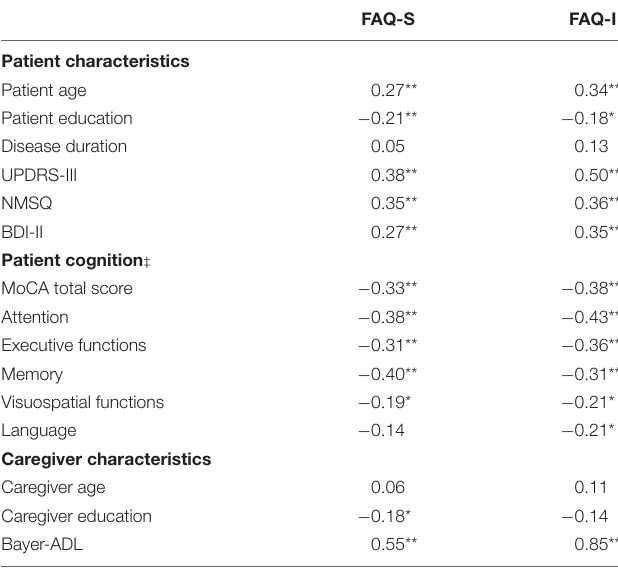
TABLE 4 | Correlations between the total FAQ-S and FAQ-I scores and both patient and caregiver variables of interest. FAQ-S